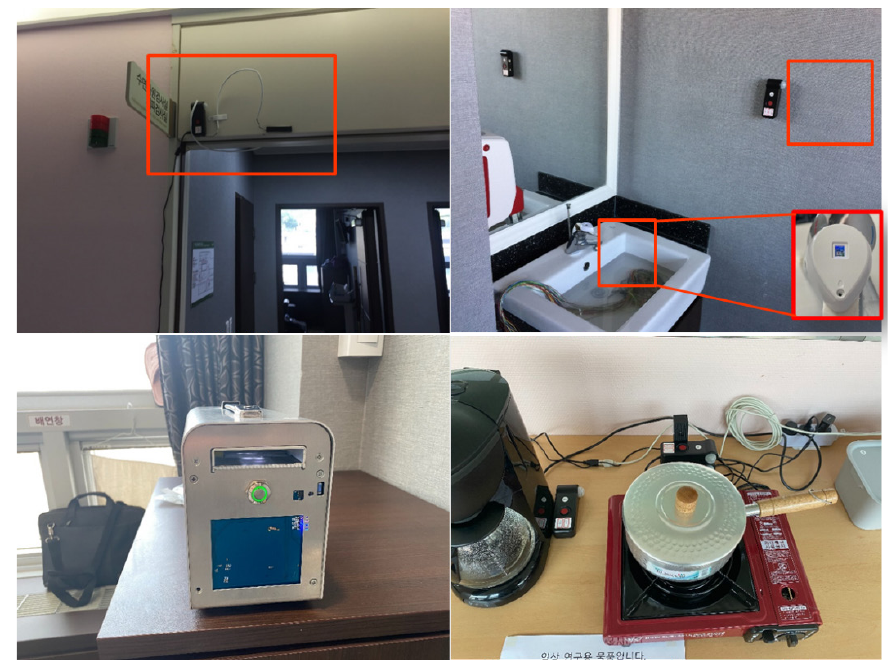
Figure 13. Installation of Resource Device for Pilot Test.